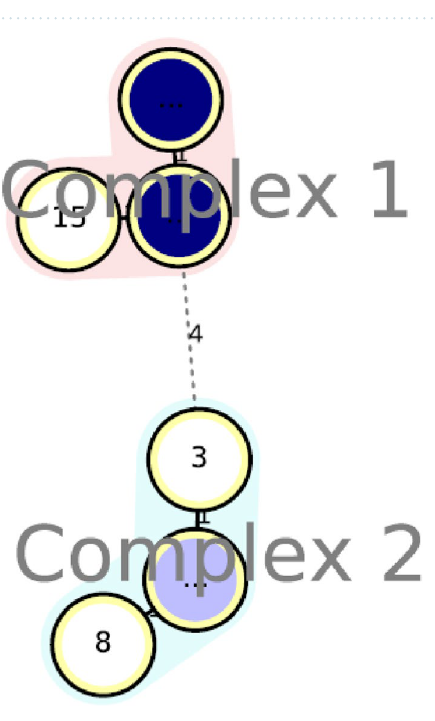
Figure 4. Minimum spanning tree (MST) based on 24-locus MIRU-VNTR demonstrating lineage classification of the 21 Mycobacterium bovis isolates. MST based on SLV (Single Locus